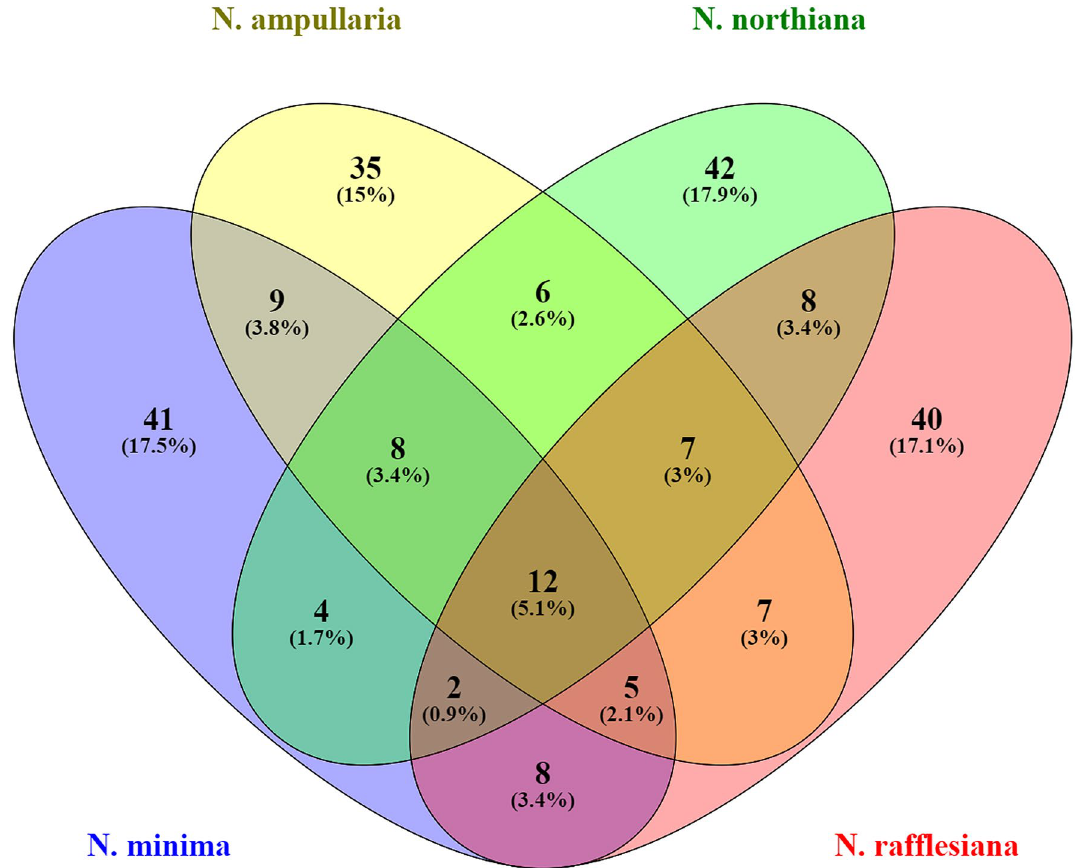
Figure 4. Venn diagram based on similarly expressed metabolites (highest expression recorded on either highland or lowland condition of the identified metabolites) among the 4 Nepenthes species in response to the three temperature conditions. Please refer to the supplementary file for the